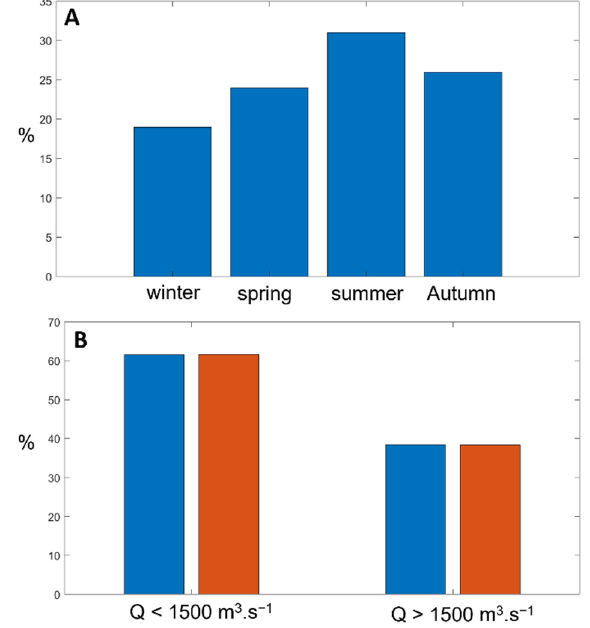
Figure A1. ( A ) Delimitation of the region of plume presence (ROPP) and the offshore SPM free rec- tangle used in MODIS dataset filtering. ( B ) Mean offshore water-leaving reflectances in the MODIS red band obtained in the offshore SPM free rectangle ( A ) for all cloud-free MODIS images in the year 2014. The ρ w (R) values are plotted as a function of days and modeled with a Gaussian curve. MODIS images with differences between the offshore reflectances and the modeled reflectances larger than 1.5 times the standard deviation of the offshore reflectances were considered outliers and excluded from the dataset.